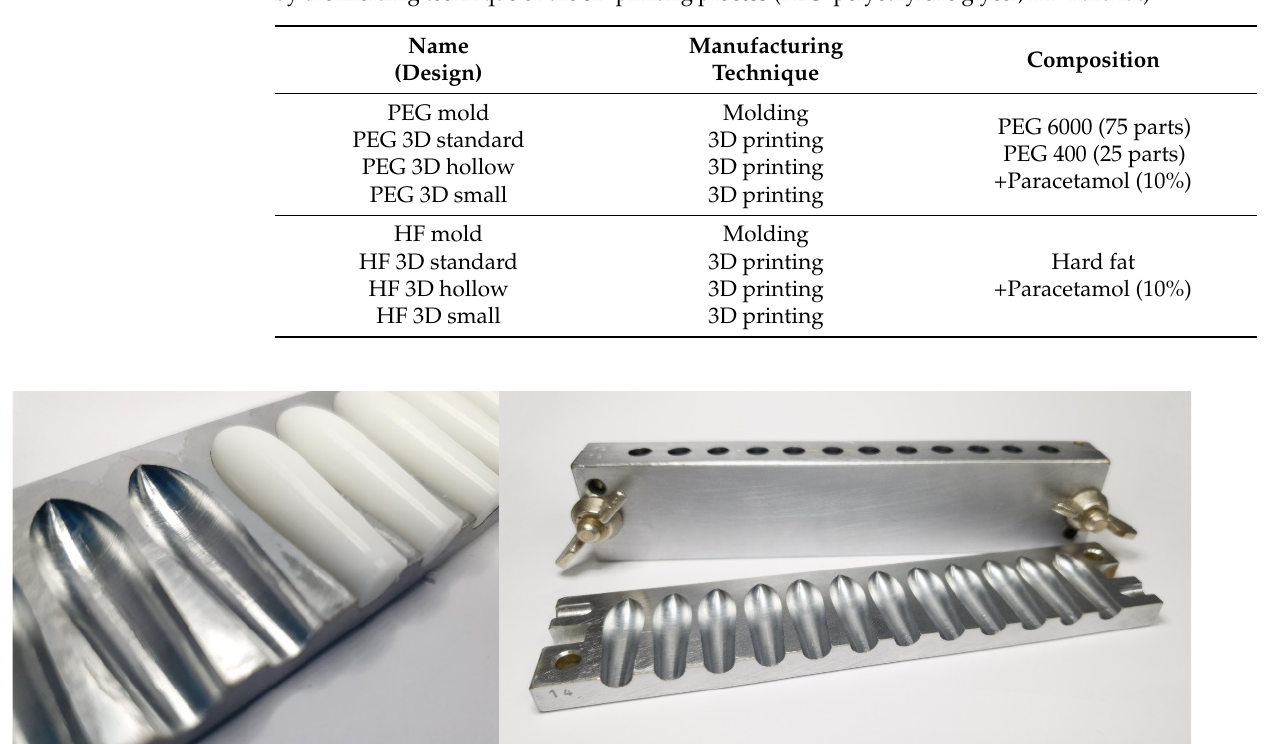
Table 1. Overviewofthecompositionandpreparationtechniquesofthesuppositorybatchesmanufactured by the molding technique or the 3D printing process (PEG: polyethylene glycol, HF: hard fat).